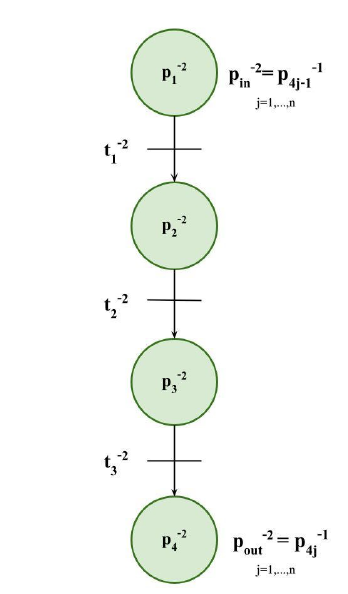
Figure 12. Modeling Petri net layer −